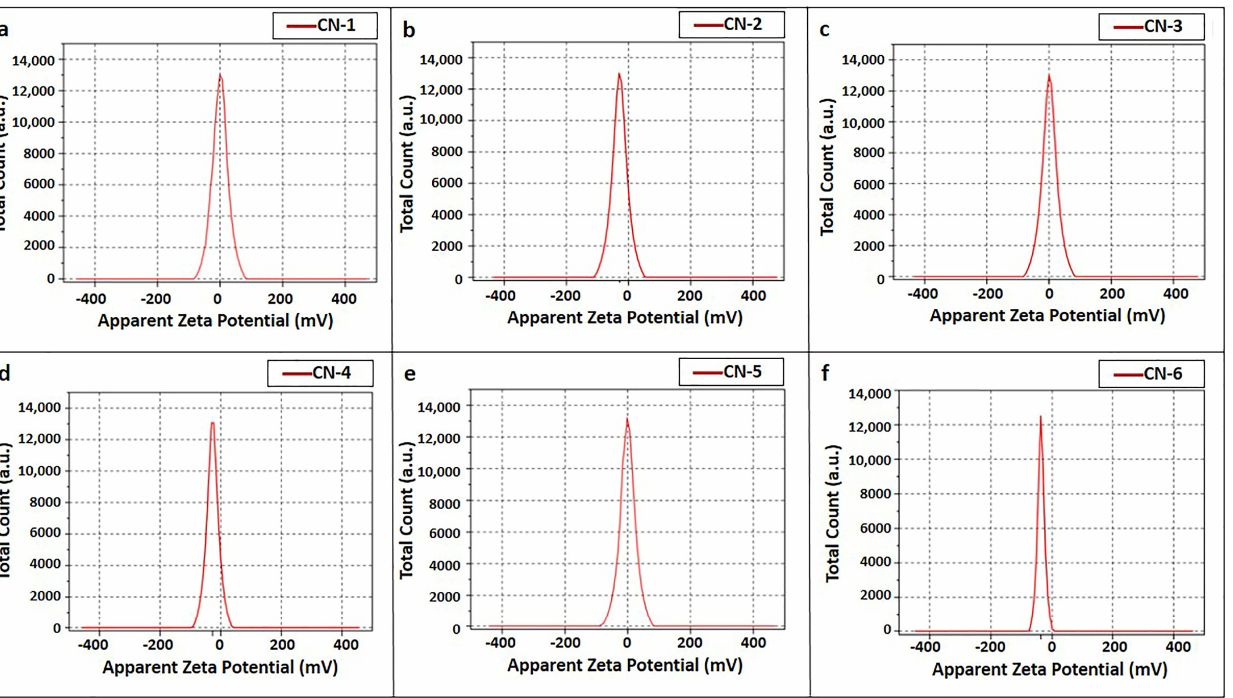
Figure 2. Zeta potential curves from the CNC suspension sample by the Nano Zeta Sizer: ( a ) CN-1, ( b ) CN-2, ( c ) CN-3, ( d ) CN-4, ( e ) CN-5, and ( f )